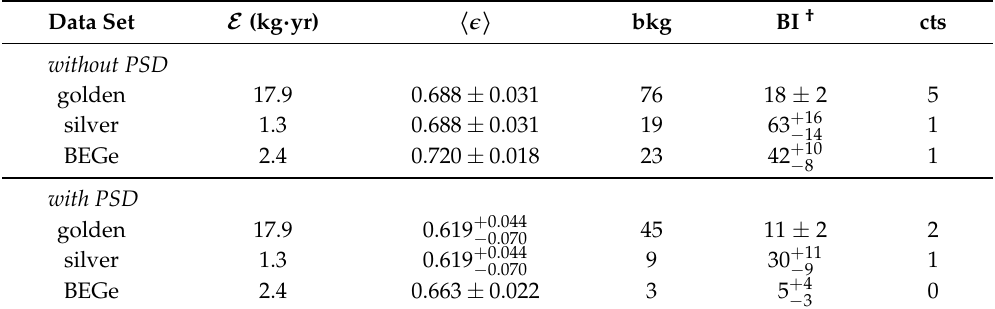
Table 3. The main facts of the three Phase I data sets when (non) applying the pulse shape dis- crimination (PSD). “bkg” is the number of events in the 230 keV window, and BI is the respective background index, calculated as bkg/( 230 keV). “cts” is the observed number of events in the E · interval Q ββ 5 ±